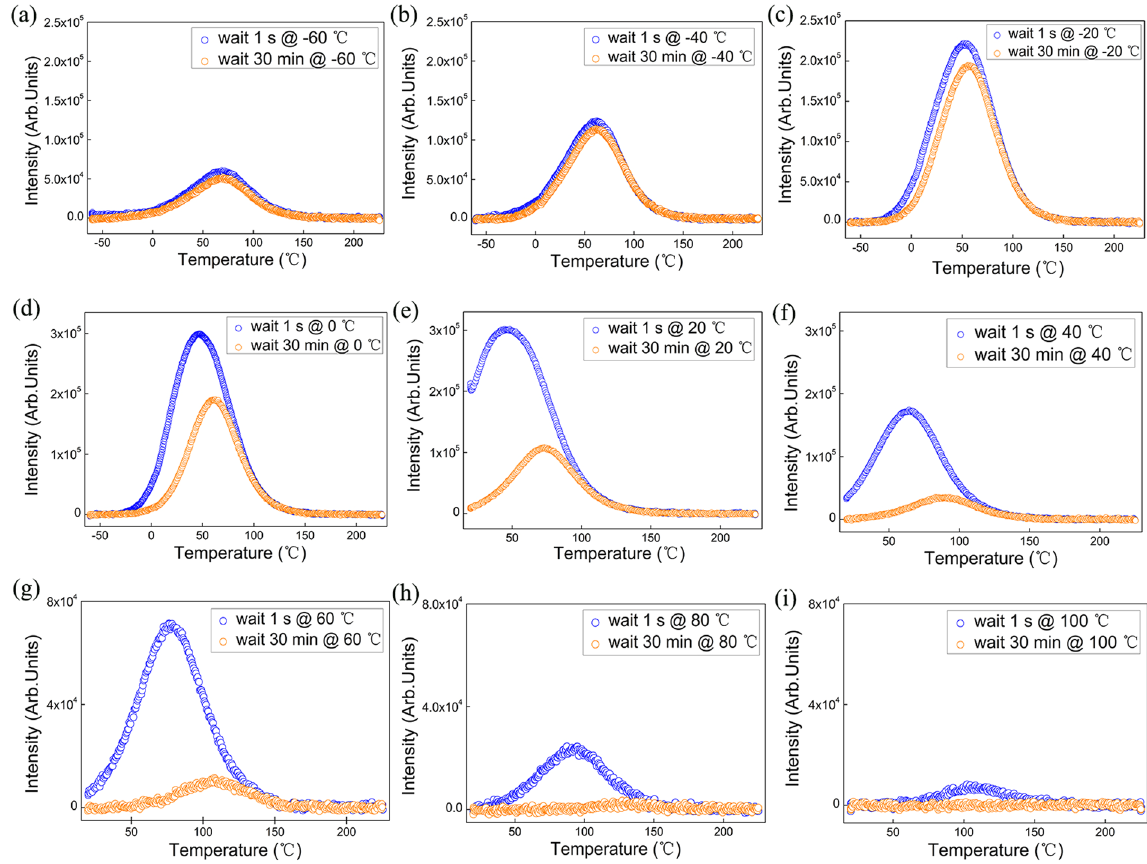
Figure 3. ( a – i ) TL glow curves of Sr 2 MgSi 2 O 7 :Eu 2 + , Dy 3 + (SMSO) at various charging temperatures for different fading times (after irradiation for 10 min at charging temperature from − 60 °C to 100 °C, fading time was chosen as 1 s or 30 min, and TL curves were collected with a constant heating rate of 30 °C min − 1